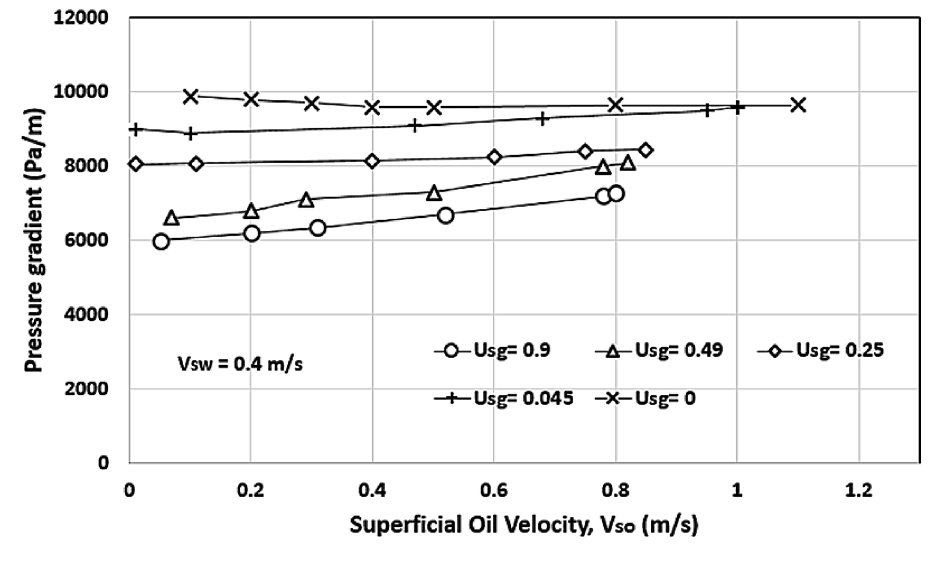
Fig. 6 Total pressure gradient in